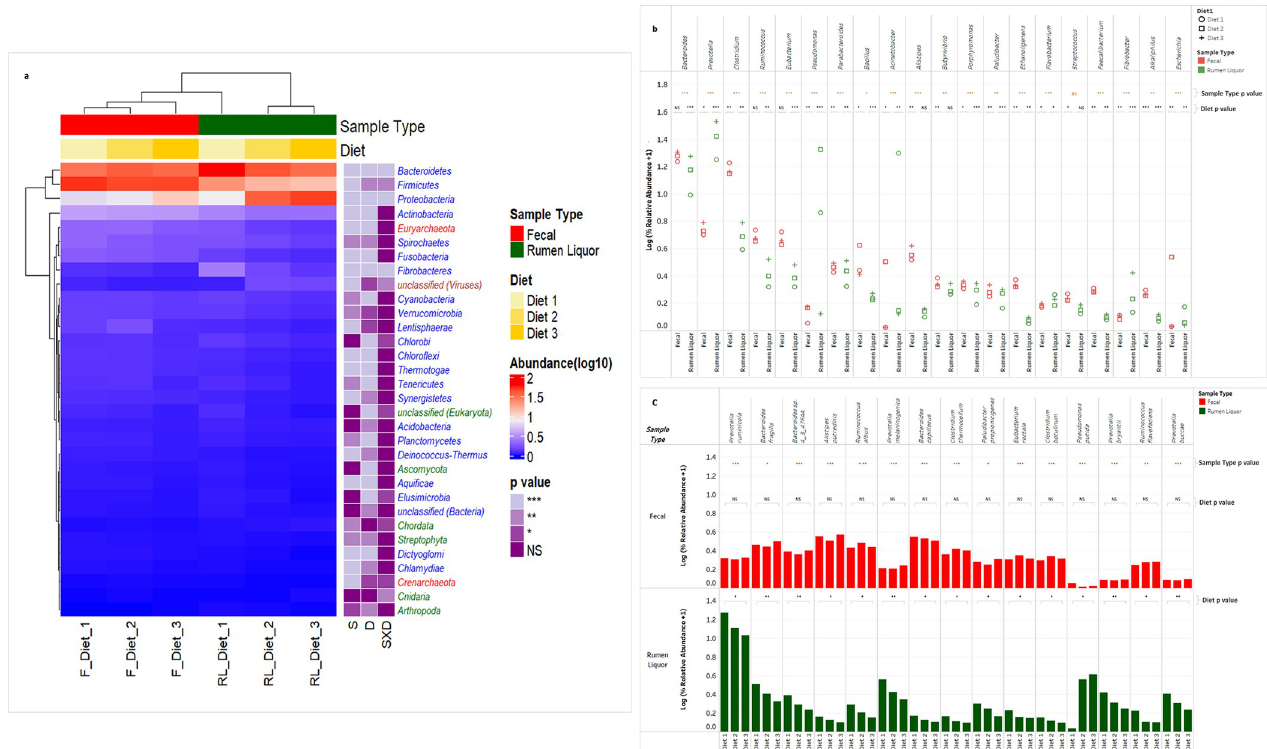
Fig 3. Comparison of relative abundance of most abundant taxa within diets in each sample type and between fecal and rumen liquor sample types. a. heatmap hierarchical clustering of most abundant phyla. In the heatmap, F = fecal, RL = rumen liquor, S = sample type, D = diet and SXD = sample type X diet interaction. Phyla color correspond to domain, blue = Bacteria , red = Archaea , green = Eucharyota and brown = Virus . NS = Not Significant, � = Significant at p = 0.05, �� = Significant at p = 0.01, ��� = Significant at p = 0.001. b. scatter plot of 20 most abundant genera, and c. bar chart of 15 most abundant species. In fig b and c, a log transformed scale of the relative abundances is used for beater visualization of low abundance taxa.